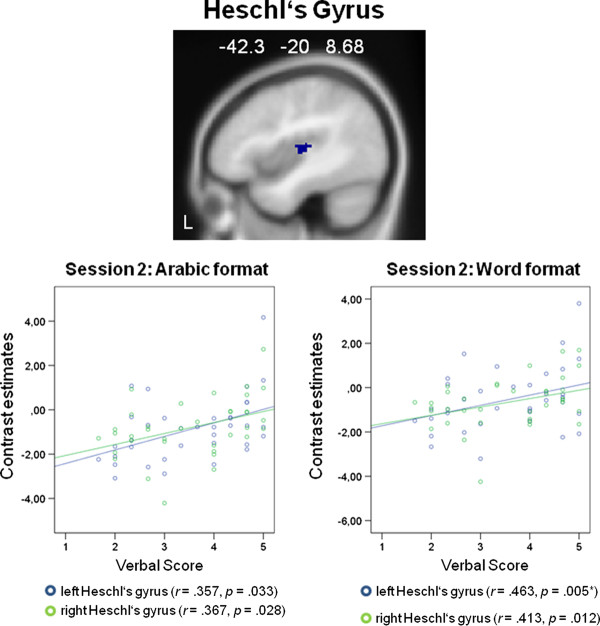
ROI analysis results: Heschl's Gyrus. Significant correlations between peak activations in the Heschl's gyrus and the self-reported use of verbalization: In the second functional session significant correlations appeared for multiplications presented with written number words and the right and left [* correlation passes the Bonferroni correction (critical p value is .006)] Heschl's Gyrus, and for multiplications presented with Arabic numerals and the right and left Heschl's Gyrus.